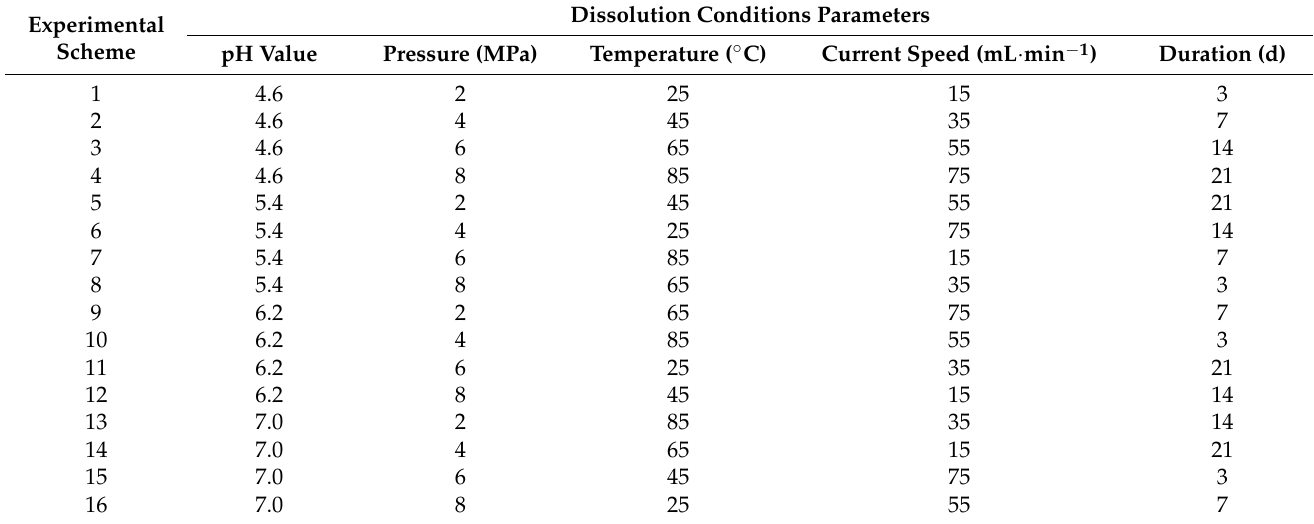
Table 4. Orthogonal numerical simulation experimental